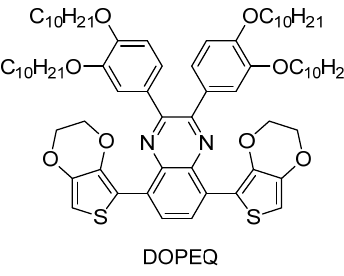
Figure 19. Chemical structure of DOPEQ.